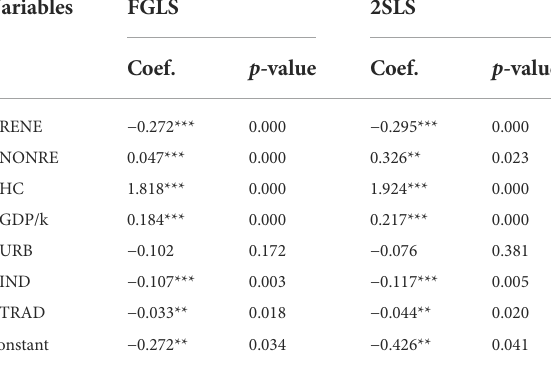
TABLE 7 Results of the linear